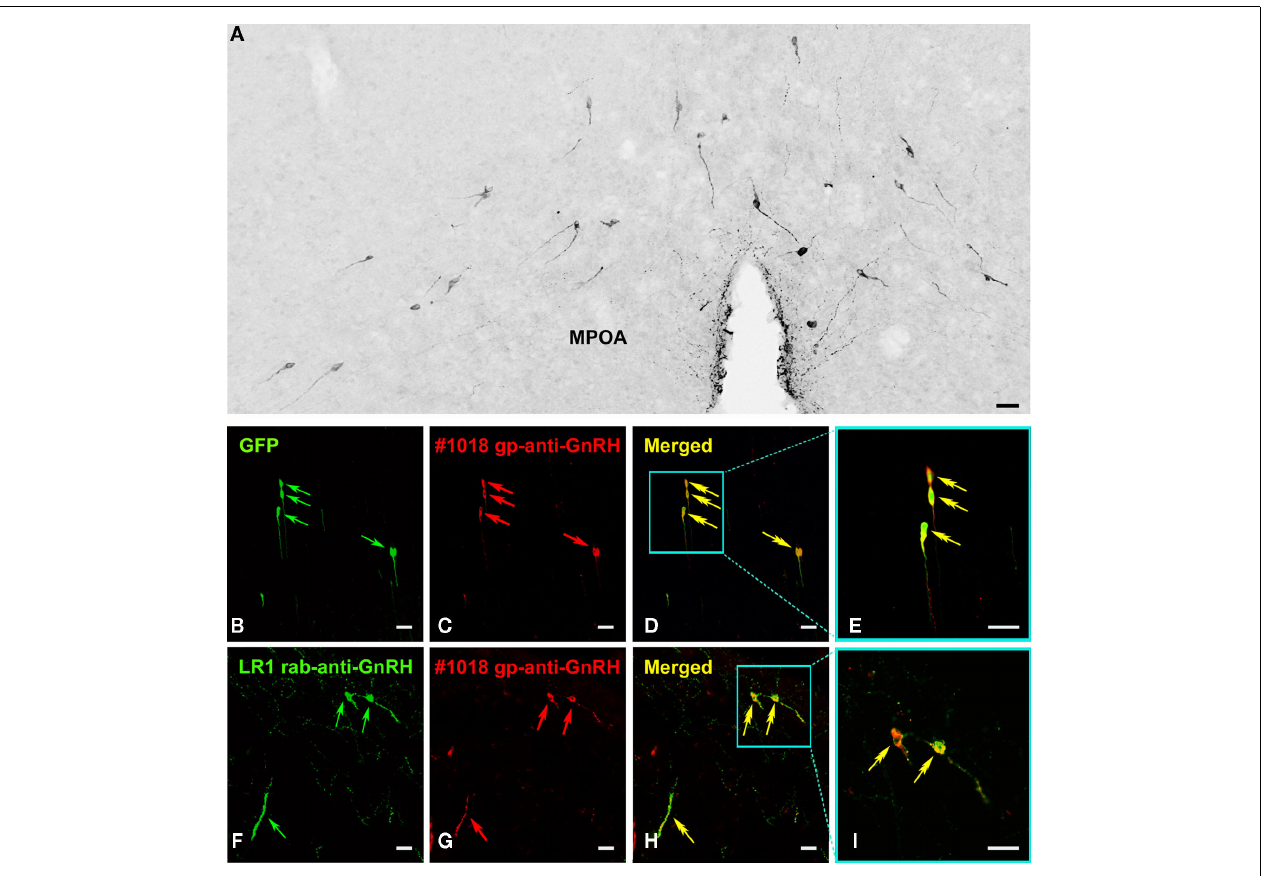
transgenic mice. Double arrows in (D) [merged from (B,C) ] and (E) [high-power image of framed region in (D) ] point to double-labeled neurons. The dual-immunofluorescent visualization of GnRH-IR neurons in the human hypothalamic infundibular nucleus provides additional evidence that a reference rabbit antiserum [LR1; (F) ] and the new guinea pig antiserum (G) recognize the same neurons. Double arrows in (H) [merged from (F,G) ] and (I) [high-power image of framed region in (H) ] point to the dual-labeled GnRH cell bodies and their processes. Scale bars = 50 μ